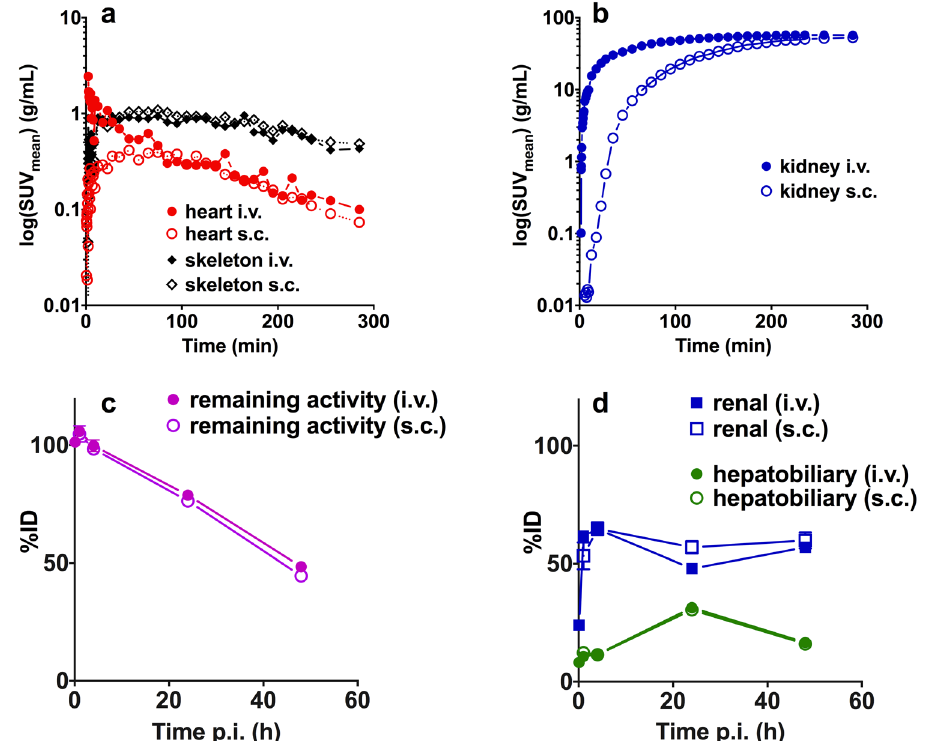
Figure 7. Kinetics in the heart, skeleton, kidneys and elimination. Representative time-activity curves of the [ 64 Cu]Cu-NOTA-HsTX1[R14A] in PET studies ( a ) heart, skeleton and ( b ) kidneys of rats after single i.v. (n = 1) or subcutaneous s.c. injection (n = 1). Biodistribution data of the ( c ) elimination of the activity from the body after single i.v. (8 animals; mean ± SEM) or s.c. (4 animals; mean ± SEM) injection and ( d ) renal and